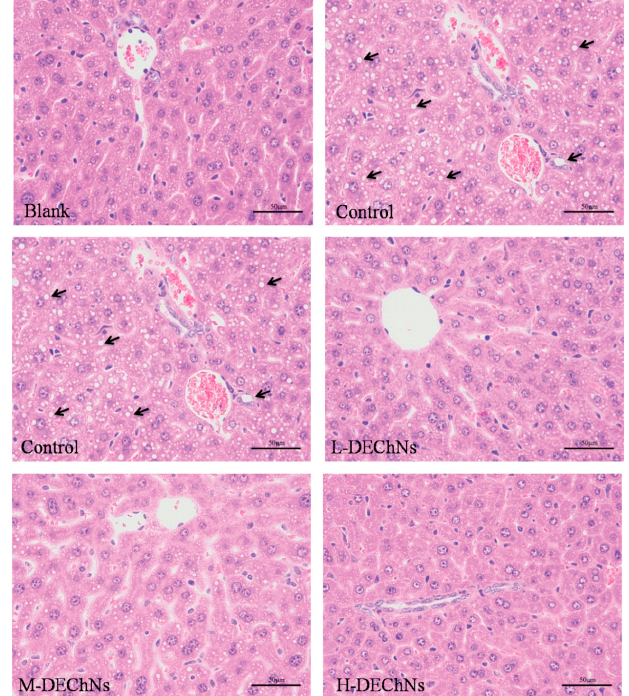
Figure 26. Histological examination of liver tissues from mice in the blank group (fed a normal diet and saline solution); control group (fed a high-fat diet and dilute acetic acid solution); and the L, M and H-DEChN groups (fed a high-fat diet and low, medium, high doses of DEChN dispersions, respectively). The arrows point out the fat vacuole in the cytoplasm [120].